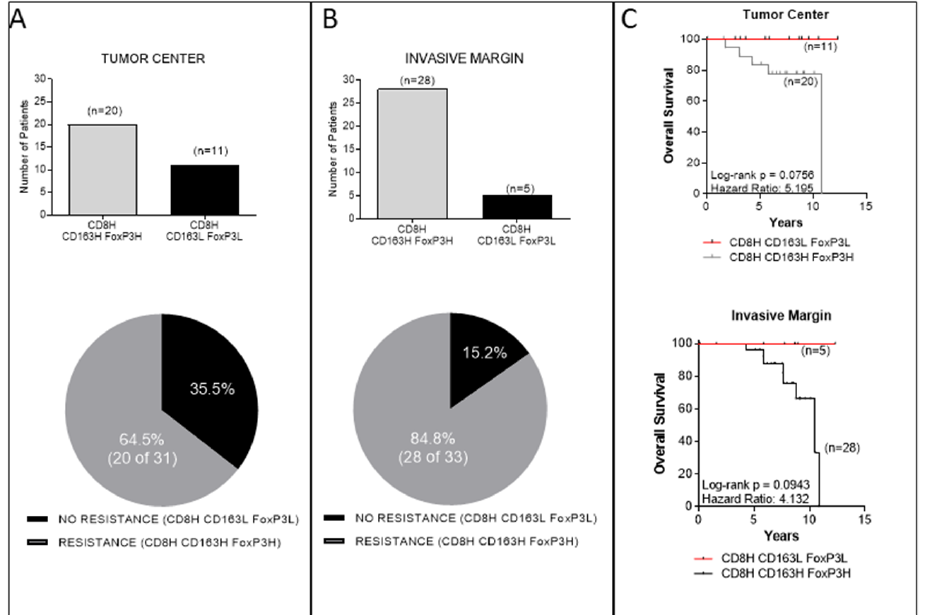
Figure 5. Association between combined densities of CD163+ and FoxP3+ cells in the context of high CD8+ densities separately in the TC and in the IM and correlation with overall survival (OS). Number of patients with high densities of CD8+, and high or low densities of CD163+ and FoxP3+ cells in TC ( A ) and in IM ( B ) and correlation with OS ( C ).